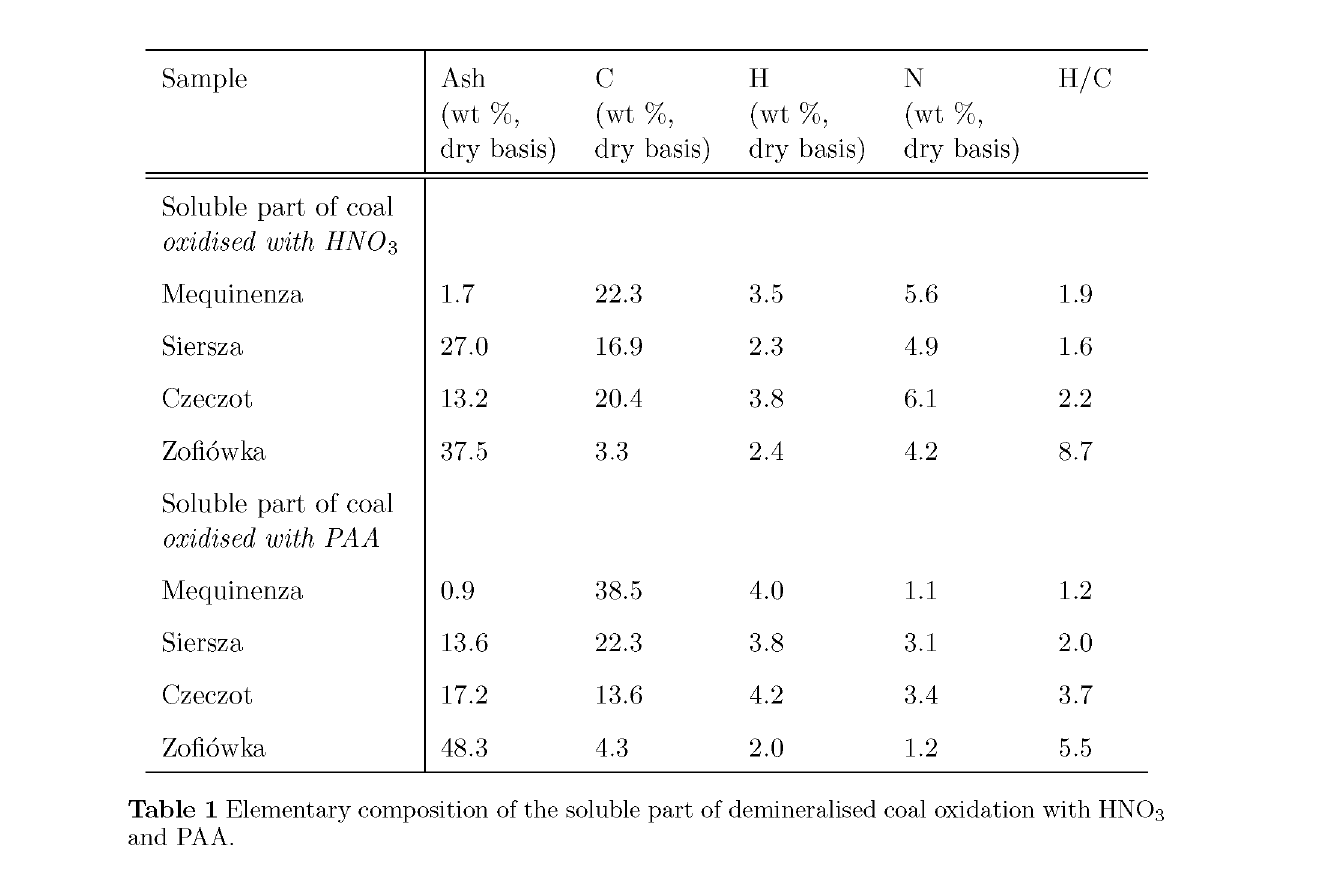
Table 1 Elementary composition of the soluble part of demineralised coal oxidation with HNO3 and